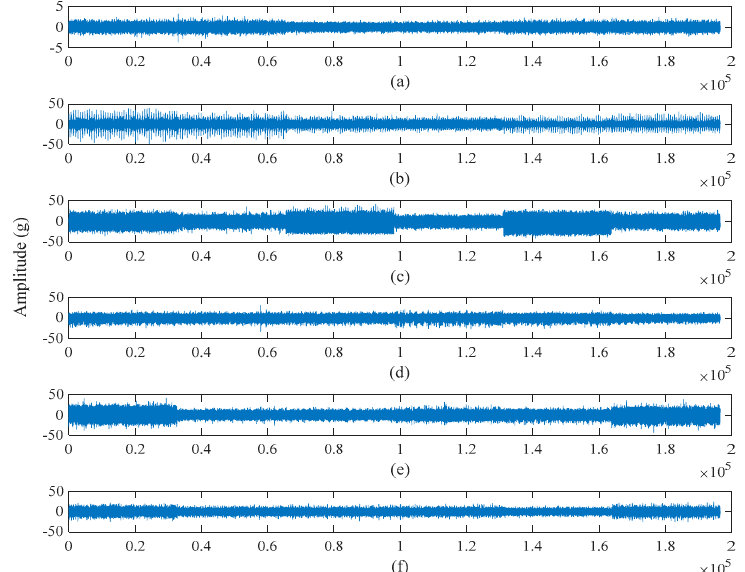
Figure 4. Six fault types of vibration signals. (a) normal signals, (b) inner race fault signals, (c) outer race fault signals, (d) cage fault signals, (e) inner and outer race fault signals, (f) inner race, ball, cage and outer race fault signals.